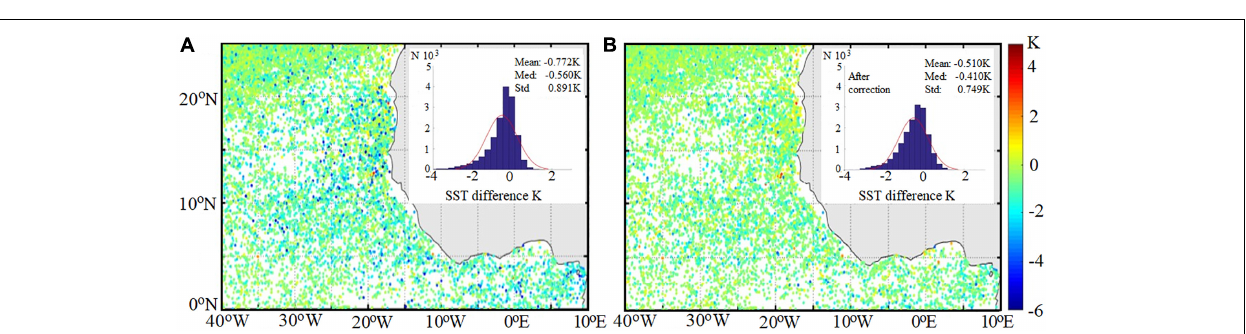
FIGURE 4 | Night-time differences between SST skin derived from MODIS on Aqua, and collocated, coincident subsurface temperatures from drifting buoys off West Africa, a region frequently subjected to the influence of Sahara dust aerosol outflows to the west and southwest, after Luo et al. (2019). The temperature differences are indicated by colors, as given on the right-hand scale in K. (A) With the standard MODIS SST skin atmospheric correction algorithm based on measurements at λ = 11 and 12 µ m (Kilpatrick et al., 2015), indicating the predominantly negative differences in the dust outflow area. (B) As at panel (A) but after additional correction for aerosol effects with an algorithm that includes measurements at λ = 3.75 and 8.96 µ